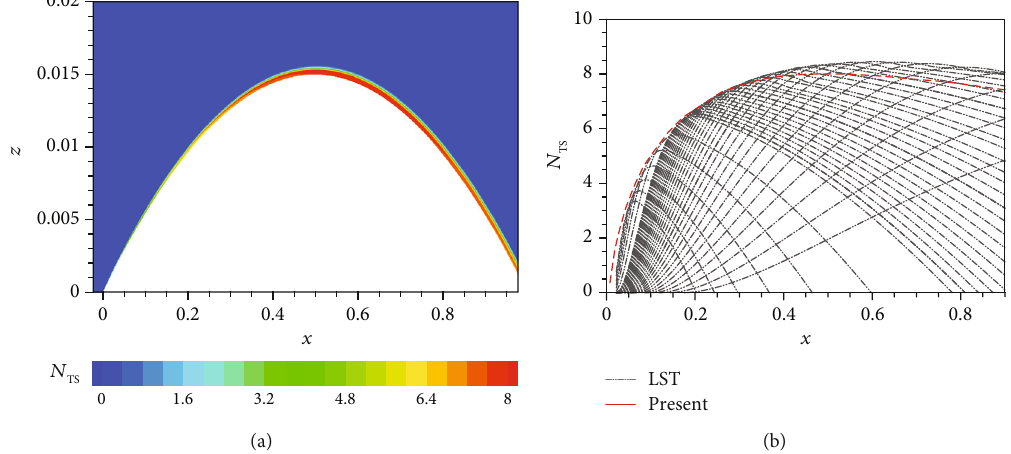
Figure 10: The predicted (a) N contour and (b) comparison with standard LST analysis results when angle of attack is 0 ° . TS